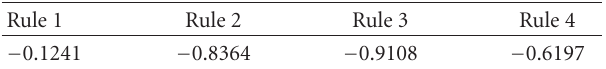
Table 3: Estimated lambda ( λ m